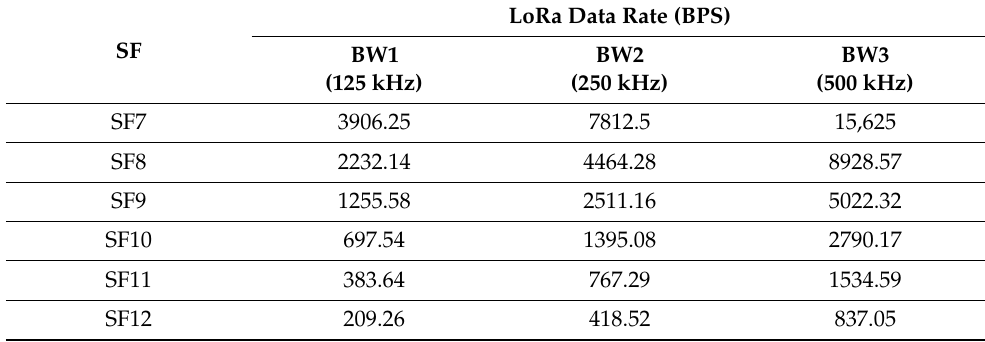
Table 7. LoRa data rate/bit rate at